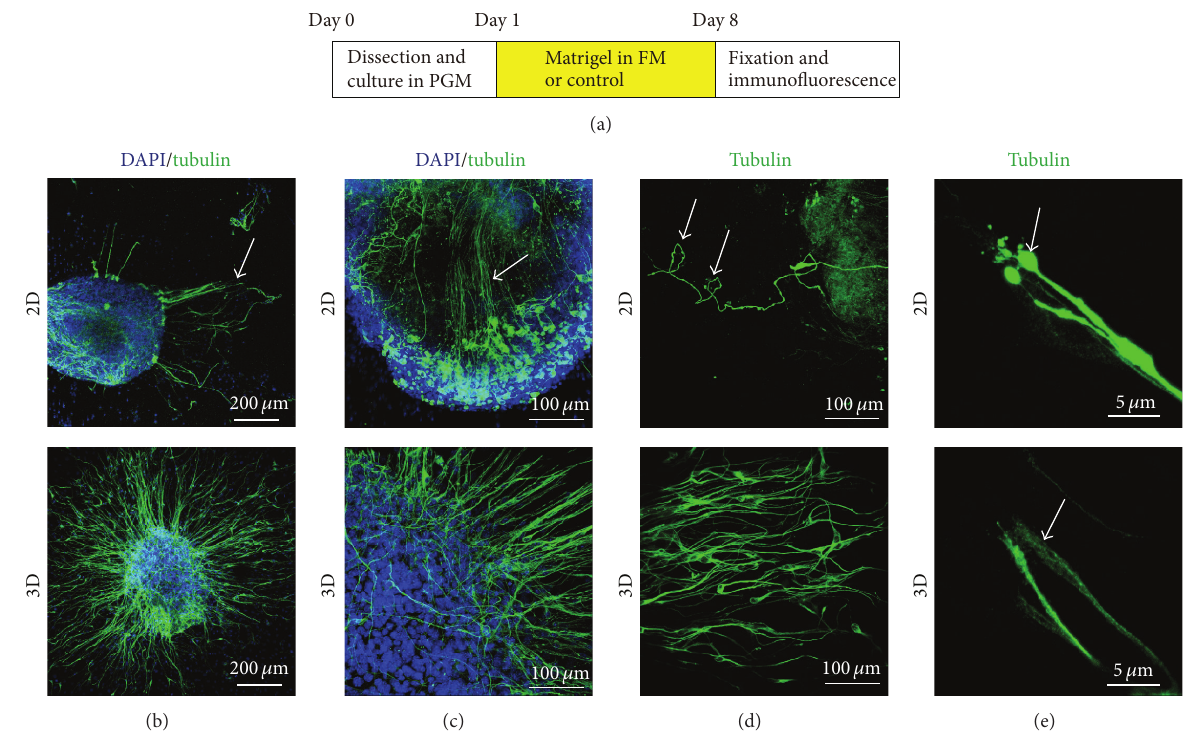
Figure 4: 3D culture preserved the delicate structure of neurites in SGN explants. (a) The diagram of the assay. Fasciculation (b), reversal (c), curling (d), and swelling (e) observed on SGN explants in 2D group. DAPI, blue; 𝛽 -tubulin,